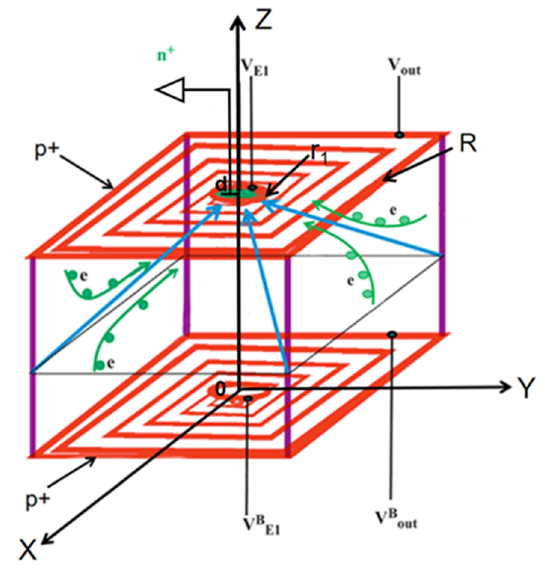
Figure 1. Structure schematic diagram